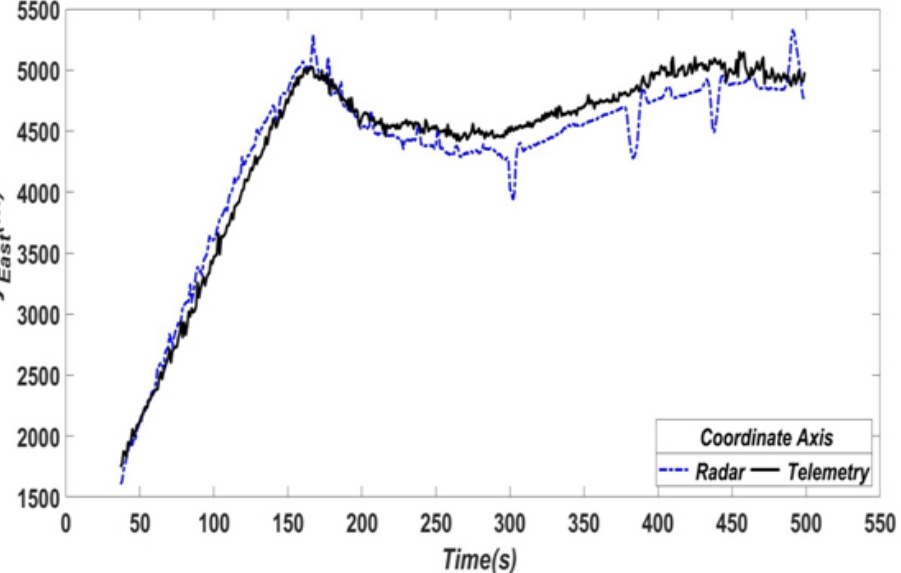
Figure 6. Comparison of radar tracking compared to Telemetry - Slant Range of the survey rocket, on the Cartesian Y-axis with respect to the rocket’s